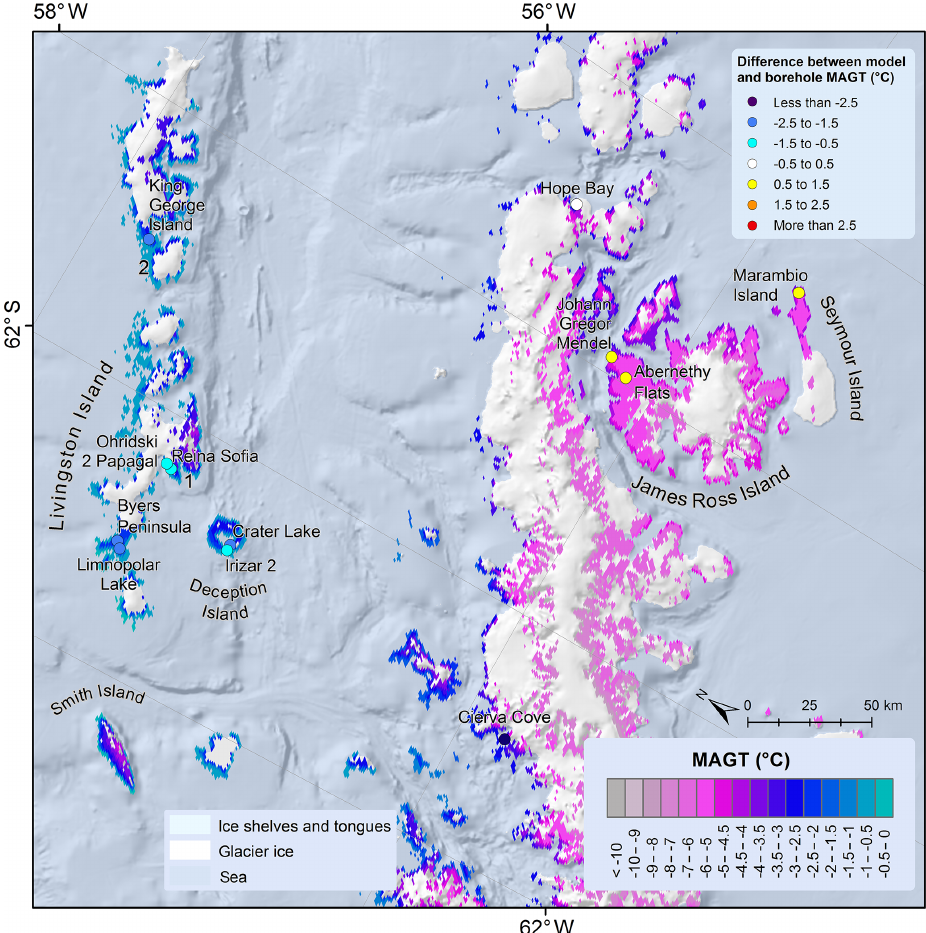
Figure 13. Permafrost temperature map of the northern Antarctic Peninsula and differences between borehole and modelled MAGT. See Fig. 1 for location. Note: the MAGT colour ramp is different from other figures. 1: Hurd Peninsula. 2: Fildes